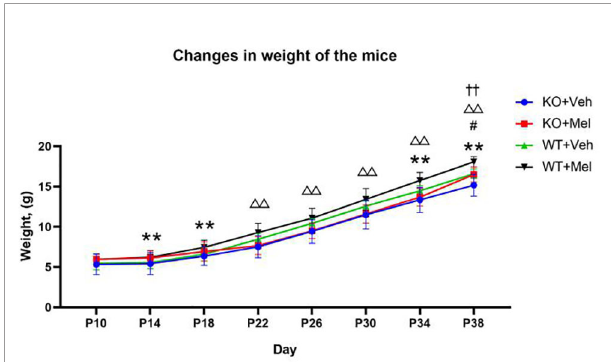
FIGURE 5 | Changes in weight of the mice: **P < 0.001 for WT+Mel vs. WT; △△ P < 0.001 for KO+Mel vs. WT+Mel; # P < 0.05 for KO+Mel vs. KO; †† P < 0.001 for KO vs. WT. [Three-way ANOVA, Bonferroni post hoc test (details are shown in